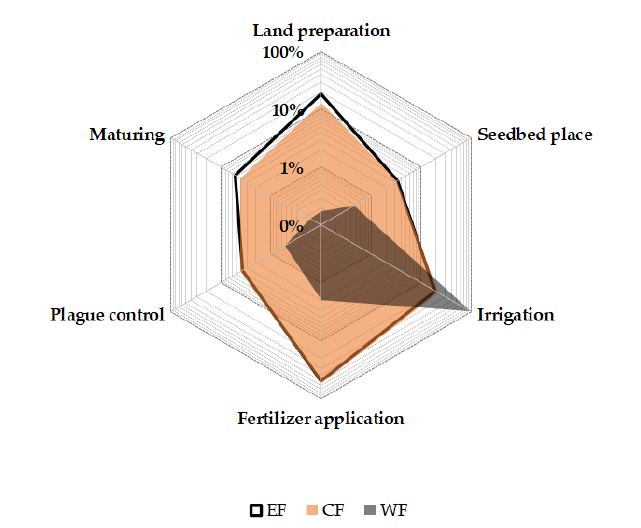
Figure 5. Environmental impacts associated with the agronomic stage.